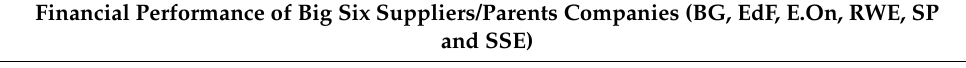
Table 6. Average financial performance of UK energy suppliers, 2010–2016 (Source: Bloomberg.Com).